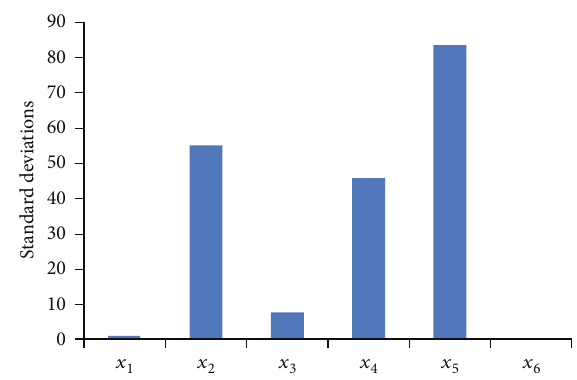
Figure 5: The comparison of the standard deviations of the